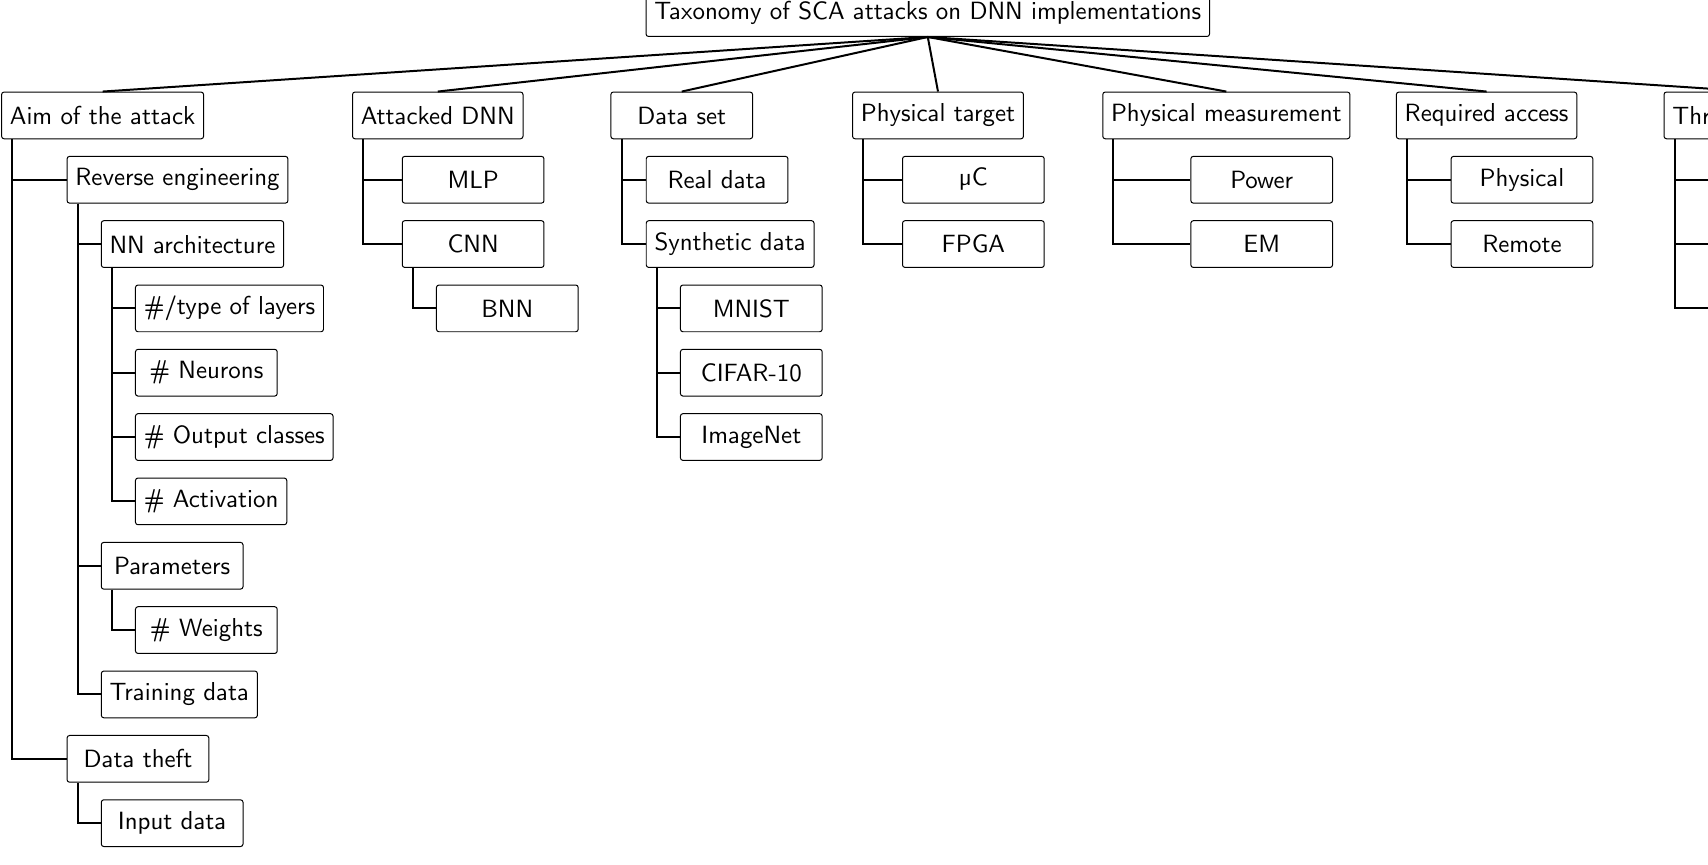
Figure 3. Taxonomy of SCA attacks on DNN implementations studied in this